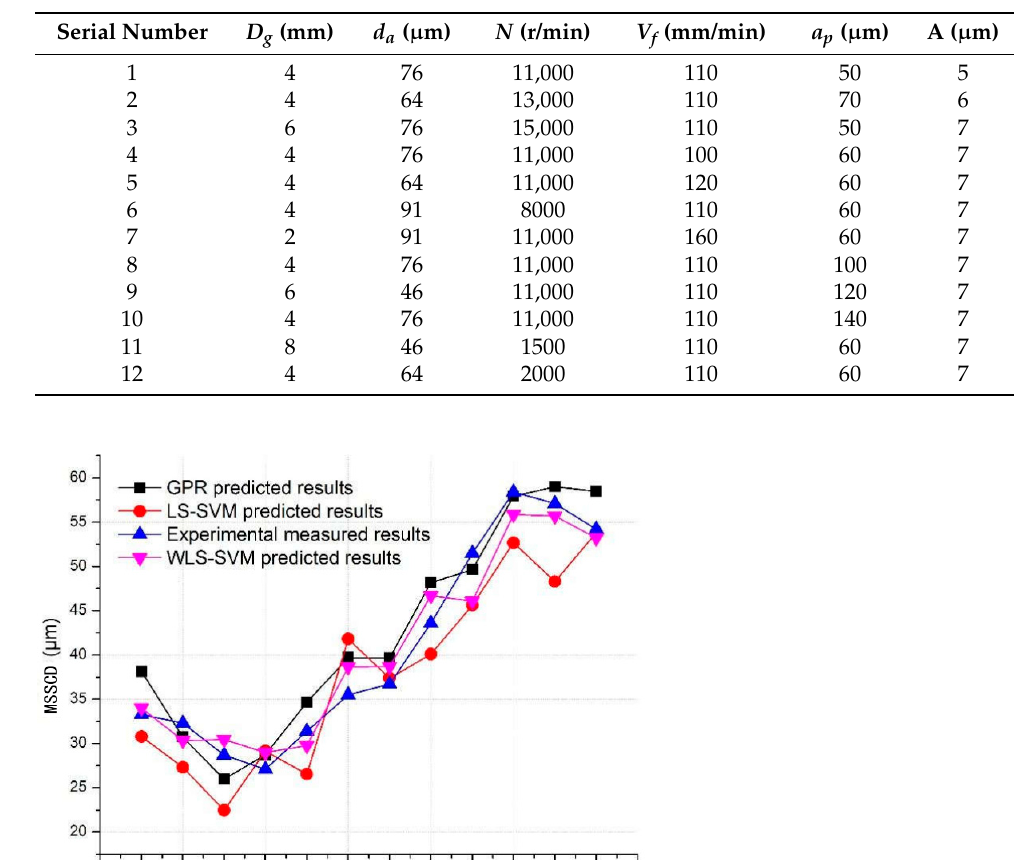
Table 5. Experimental grinding and ultrasonic vibration parameters.